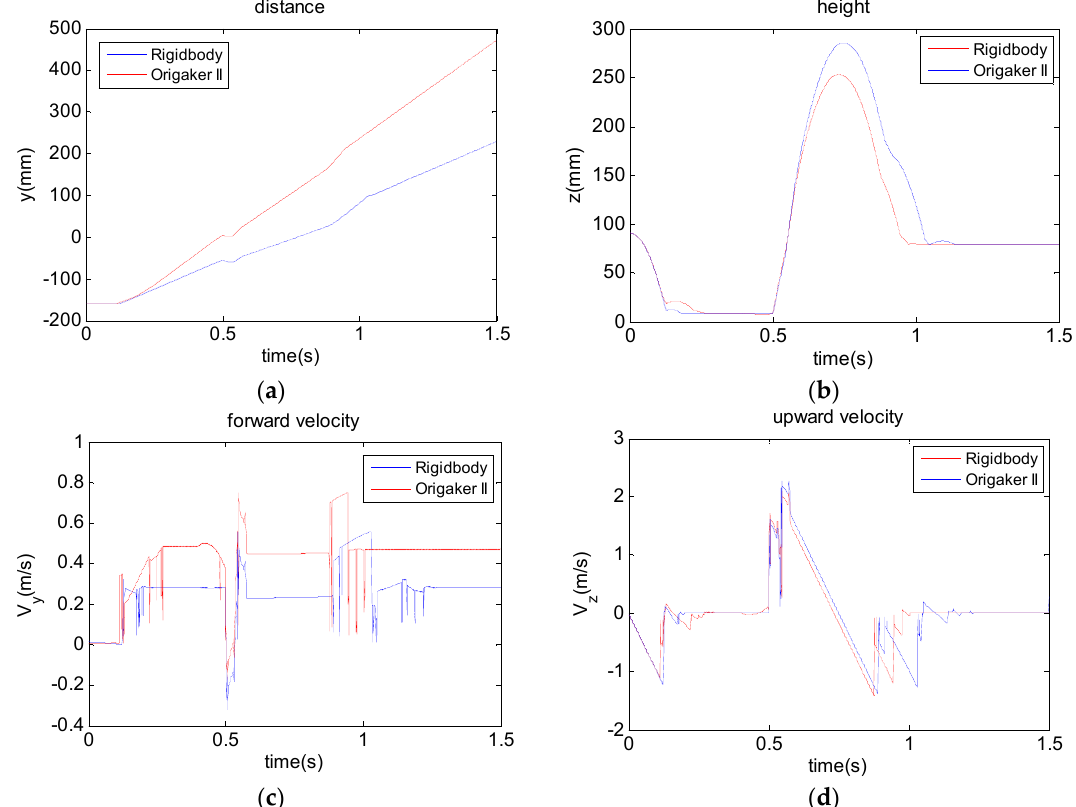
Figure 11. COG positions and velocities in y -axis and z -axis of the two robots. ( a ) The jumping distances of the two robots; ( b ) The jumping heights of the two robots; ( c ) The forward velocities of the two robots; ( d ) The upward velocities of the two robots.